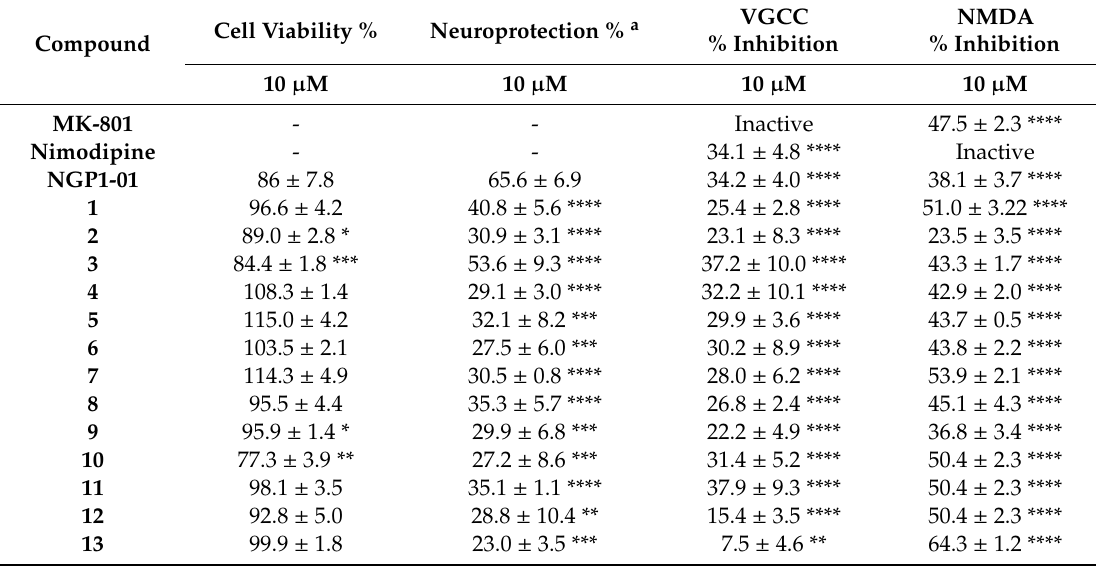
a Percentage neuroprotection values calculated as the di ff erence between the final percentage cell viability of the test compound treated cell line and that of the 2 mM MPP + only treated cell line. Data are presented as mean ±